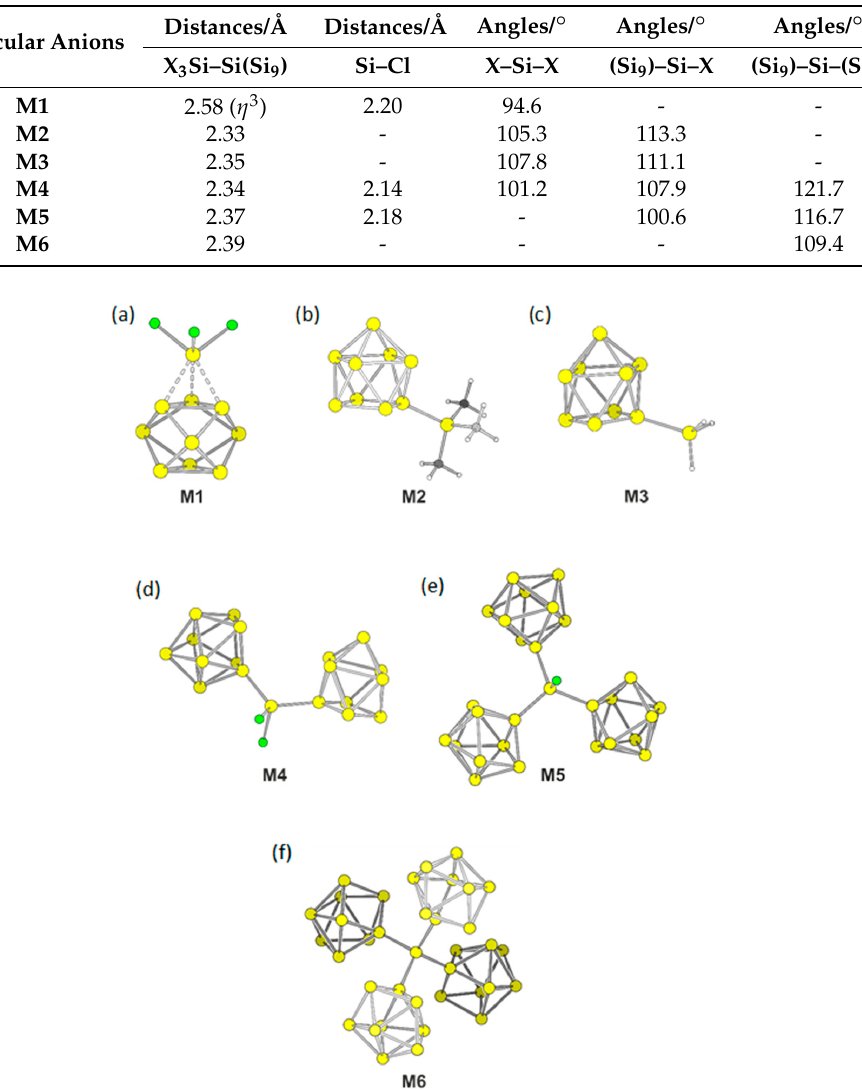
Table 1. Structural analysis of molecular anions (Figure 3). All values are averaged, if more bonds or angles of the same type exist.